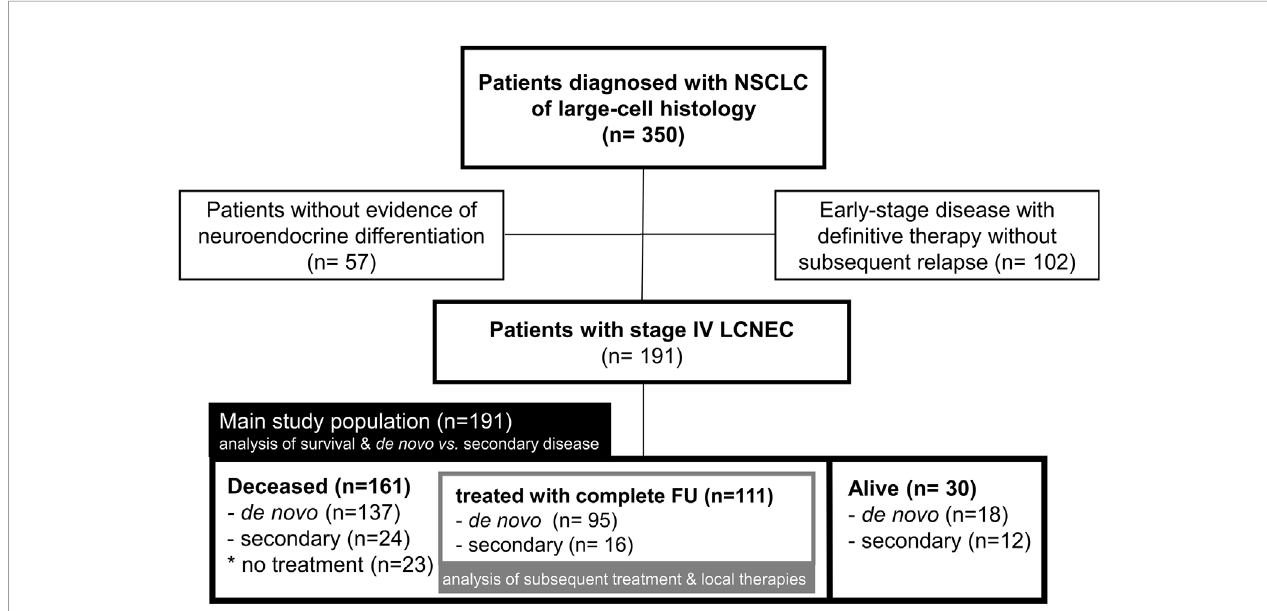
FIGURE 1 | Flowchart of study patients and the populations used in each analysis. FU,